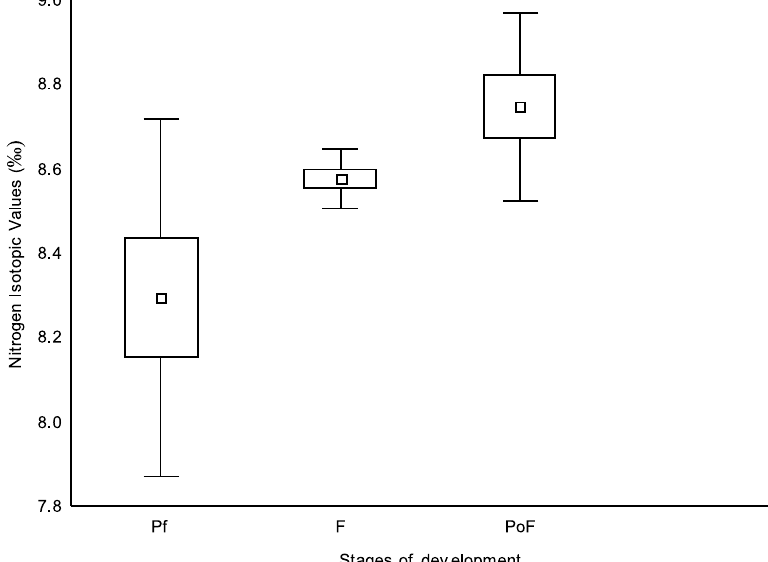
Fig. 1 – Mean values, standard error and standard deviation of the nitrogen isotope samplesduringthepreflexion(Pf), flexion(F)andpostflexion(PoF)stagesof Plagioscion squamosissimus larval development.